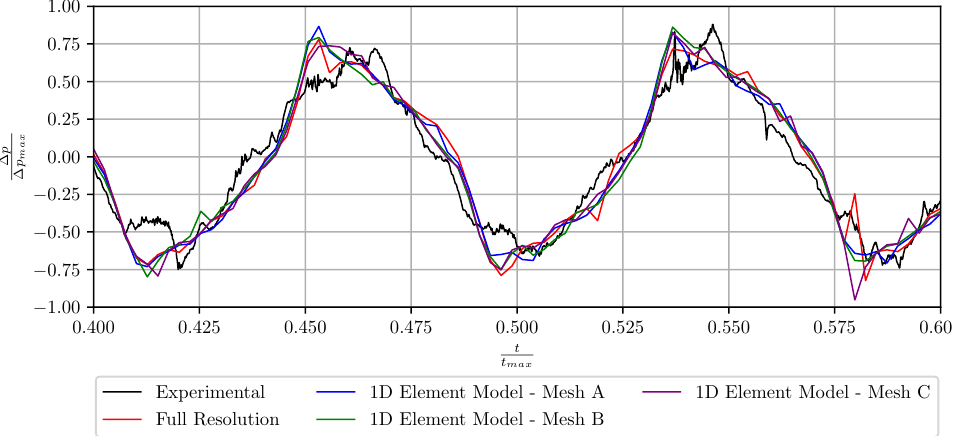
p 2 , of violent slosh test case. −